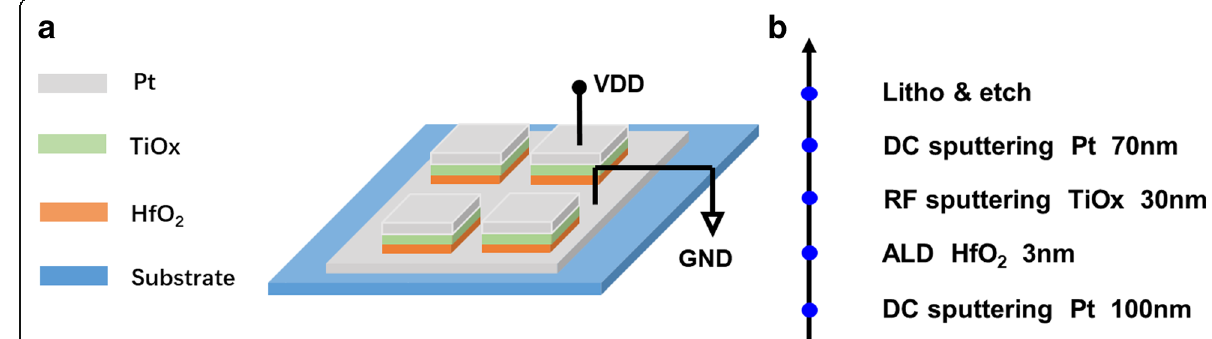
Fig. 1 a The structure of Pt/HfO2/TiO x /Pt device. b The fabrication process flow